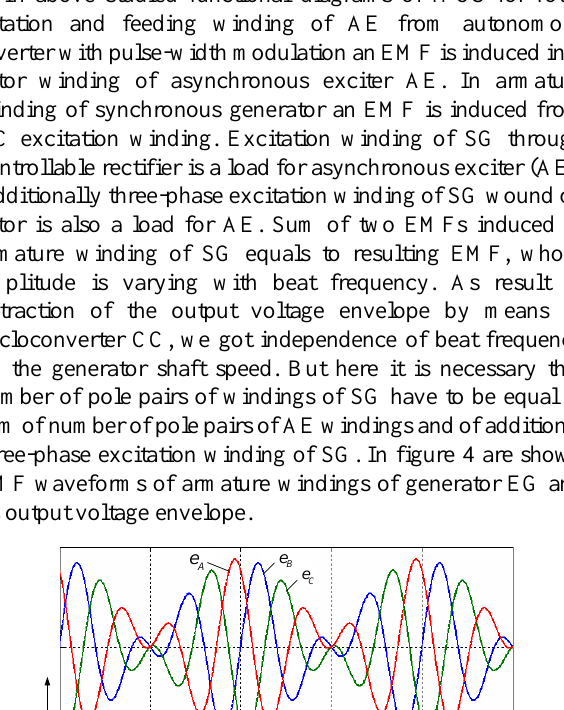
Figure 3. Functional diagram of stabilizing system of the electrical output voltage parameters of combined type